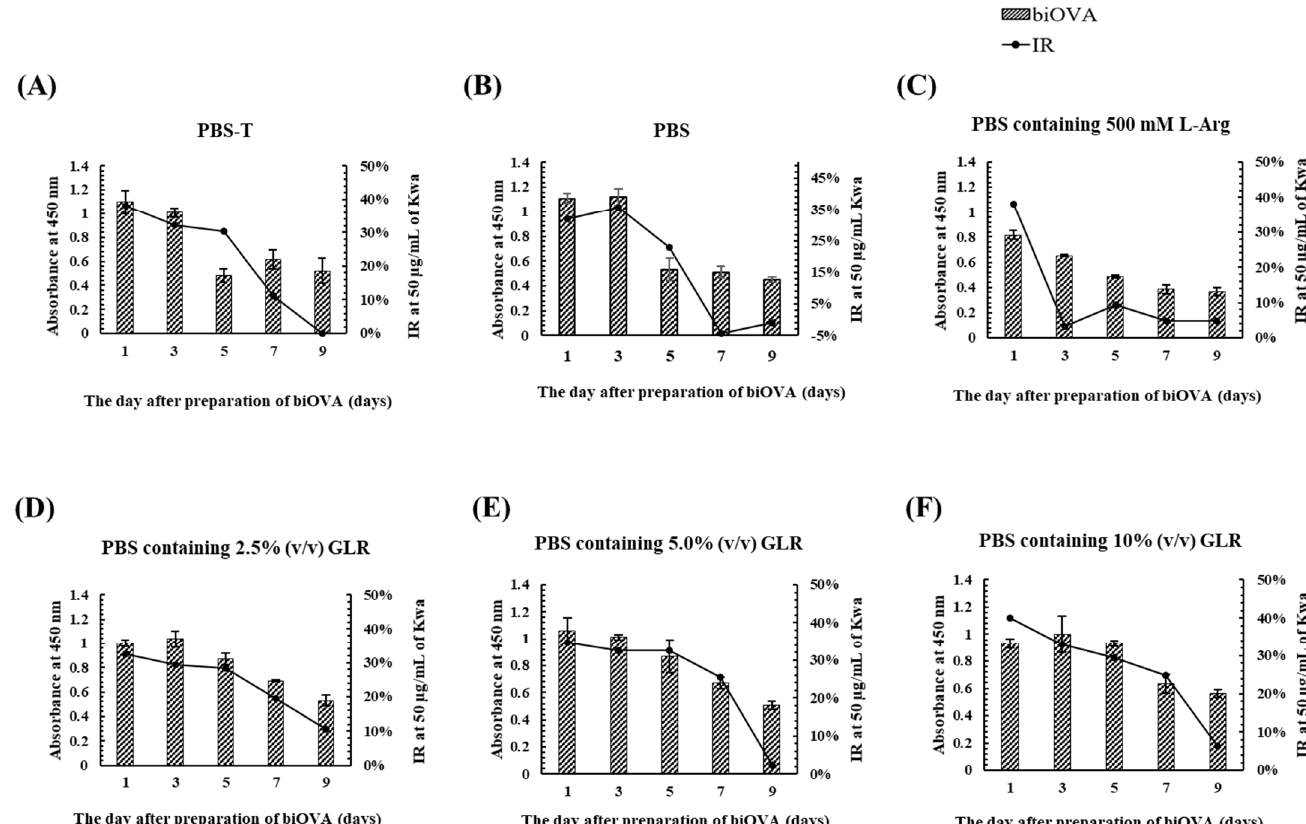
Figure 4. The effect of various dialysis buffers on the stability of biOVA evaluated by iELISA and icELISA. ( A ) PBS-T, ( B ) PBS, ( C ) PBS containing 500 mM Arg, ( D ) PBS containing 2.5% ( v / v ) GLR, ( E ) PBS containing 5.0% ( v / v ) GLR, and ( F ) PBS containing 10% ( v / v ) GLR were used as dialysis buffer. Free Kwa (50 µ g/mL) was used as a competitive compound for icELISA.